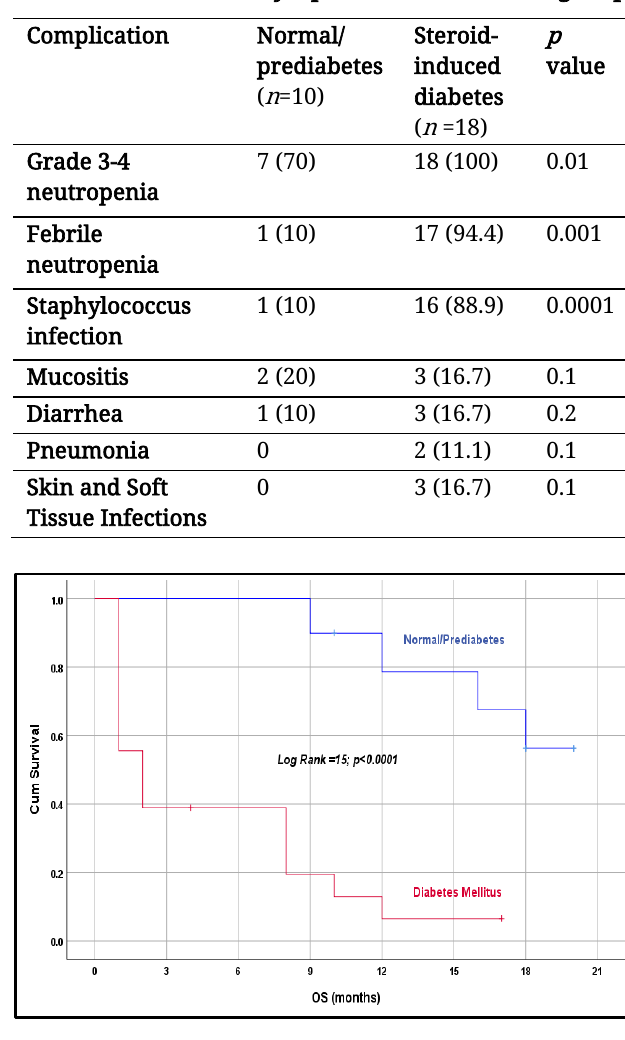
Table 2: Comparing complications between normal/ prediabetic patients and those with steroid-induced diabetes in the acute lymphoblastic leukemia group